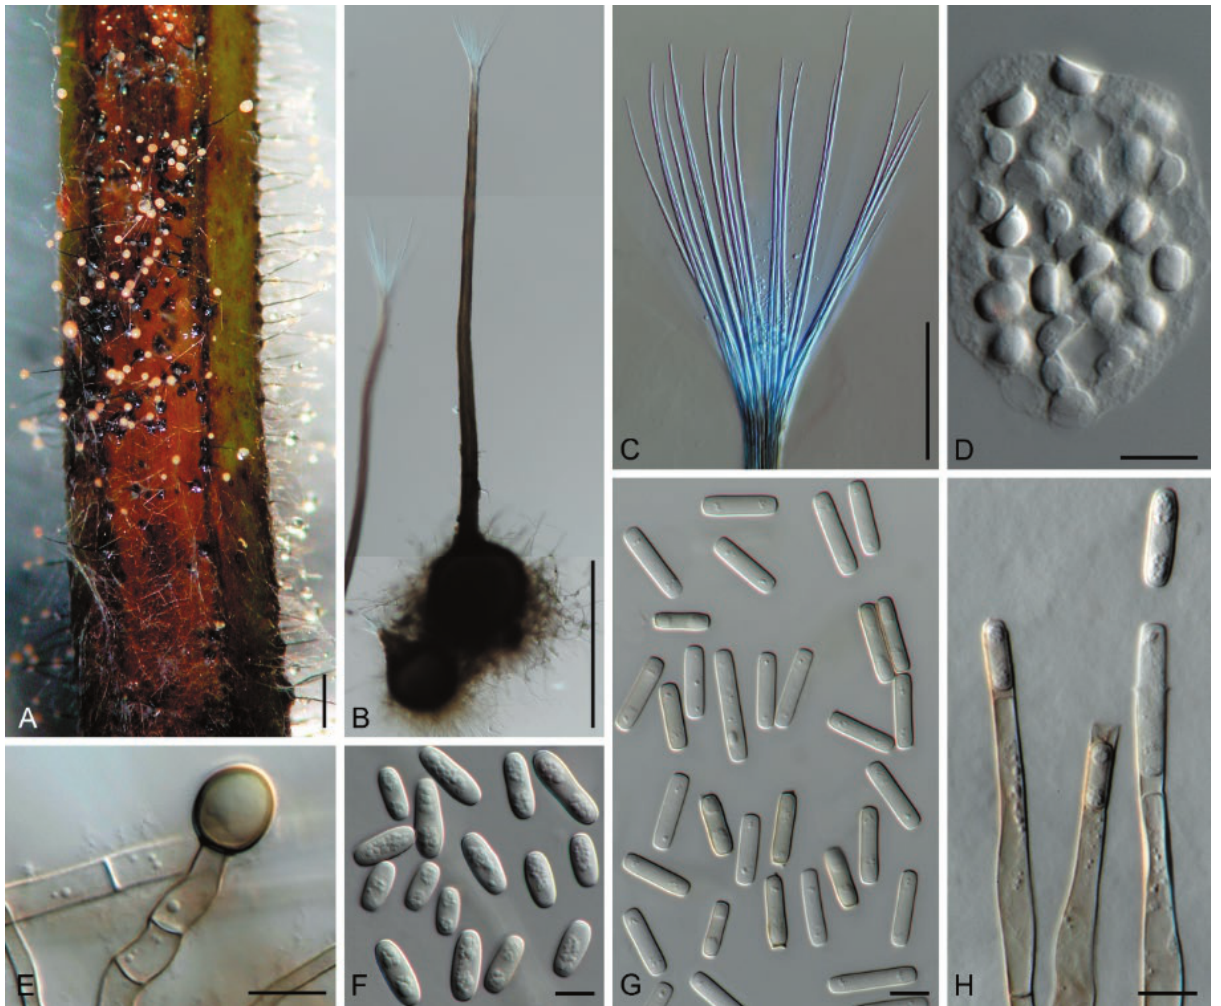
Figure 2. Microscopic features of Ceratocystis ficicola . A, ascomata on a twig bait; B, ascoma; C, ostiolar hyphae; D, ascospores; E, an aleu- rioconidium; F and G, cylindrical endoconidia; H, phialides. Scale bars: A = 1.5 mm; B = 500 µm; C = 100 µm; D to H = 10